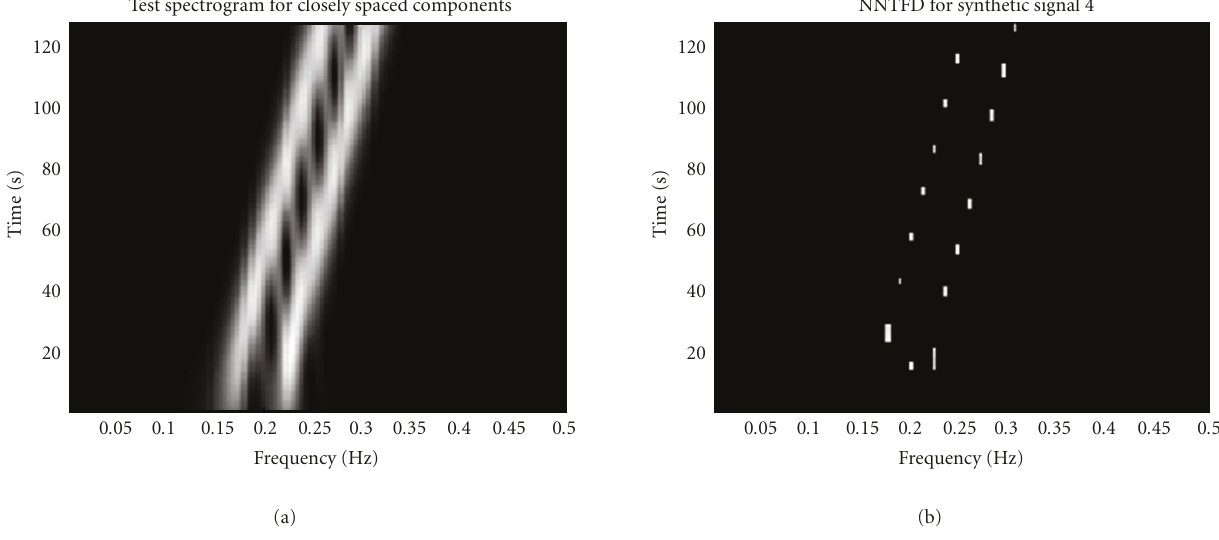
Figure 5: TFDs of a signal consisting of two linear FM components with frequencies increasing from 0.15 to 0.25 Hz and 0.2 to 0.3 Hz, respectively. (a) Spectrogram and (b)